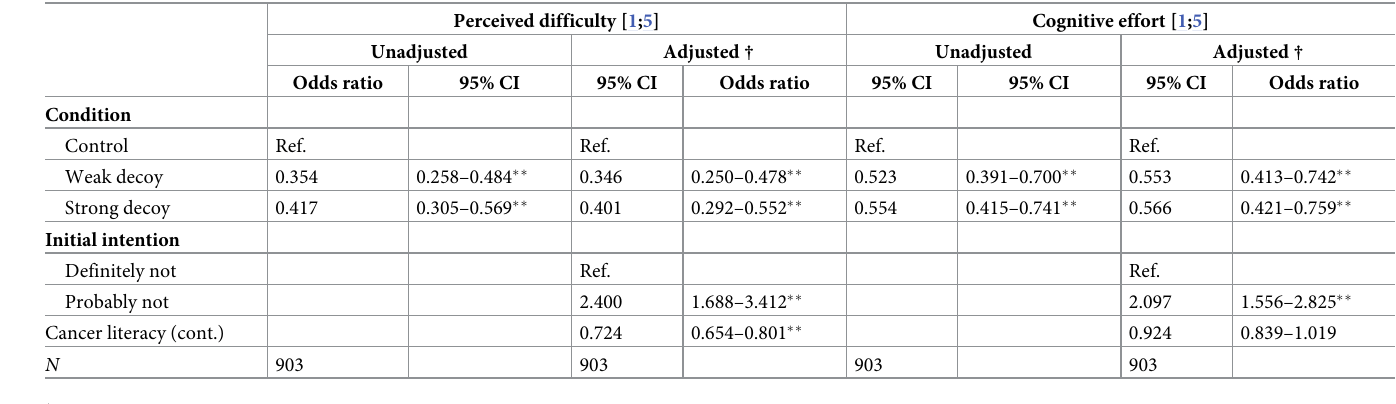
Table 4. Ordered logistic regression models on perceived difficulty and cognitive effort in Study